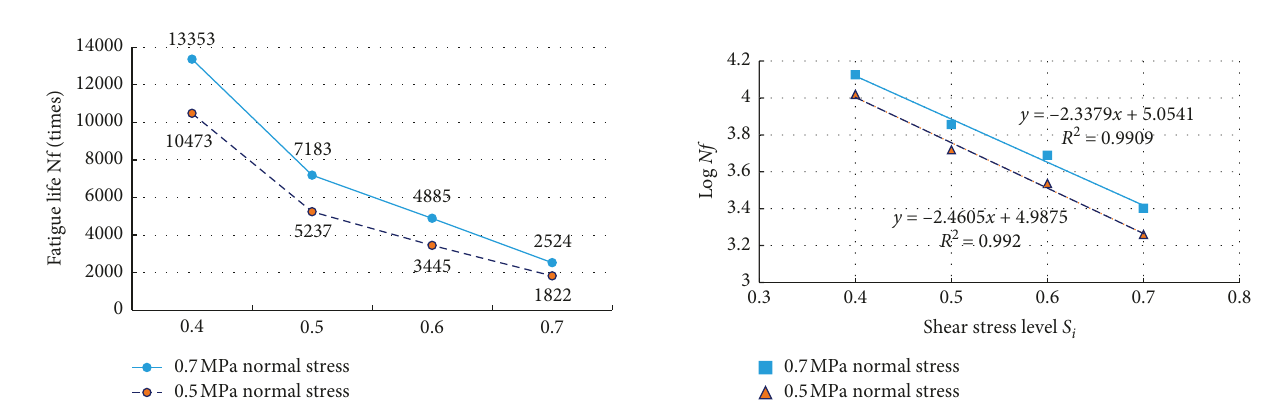
Figure 15: Relationship between fatigue life and shear stress ratio. Figure 16: Log ( N